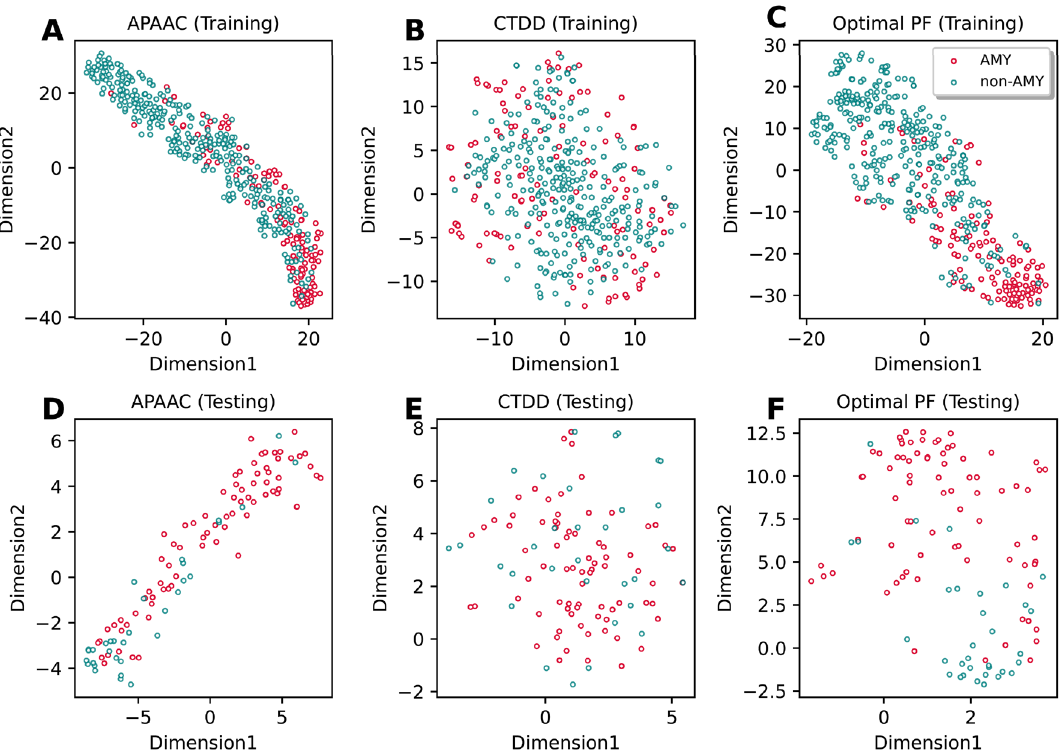
Figure 4. t‑ distributed stochastic neighbor embedding ( t -SNE) distribution of positive and negative samples on training ( A – C ) and independent test ( D – F ) datasets. APAAC ( A , D ), CTDD ( B , E ) and Optimal PF ( C , F